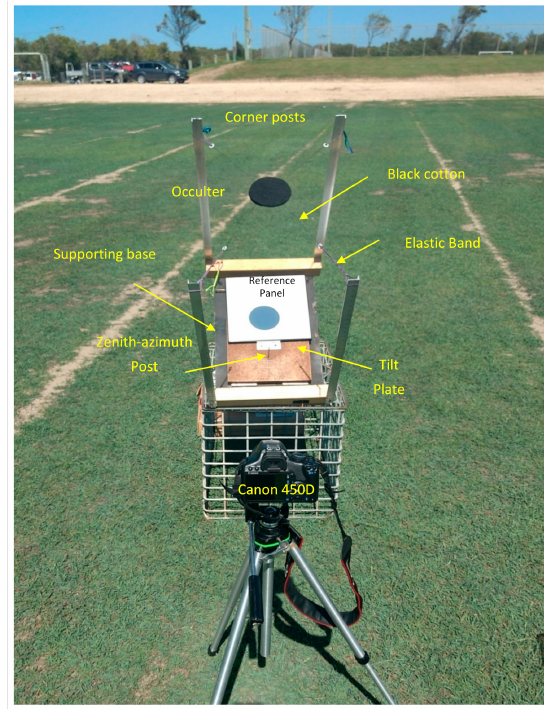
Figure 6. Canon450Dphotocaptureshowingopenframe, blacksupportingbase, browntiltplate, reference panel, suspended occulter, zenith / azimuth post set at 0 ◦ zenith and Canon 450D camera with